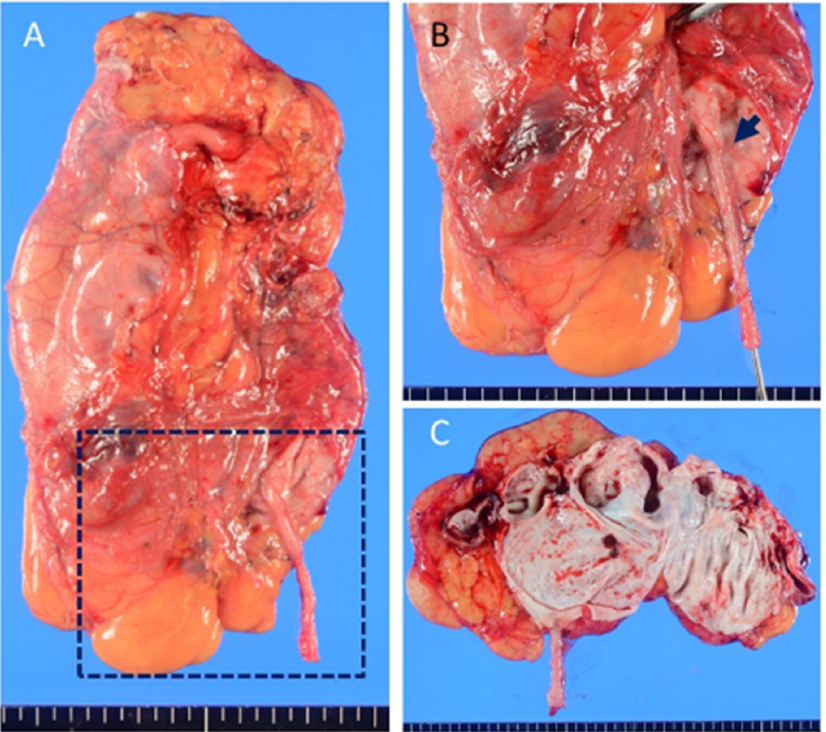
Figure 3. Gross image of the right kidney specimen ( A ). A higher magnification image of the dotted rectangle in ( A ) shows the site of right ureteral stenosis indicated by the blue arrow ( B ). The lumen of the cortex of the right kidney was paper ‐ thin and multilocular ( C ).